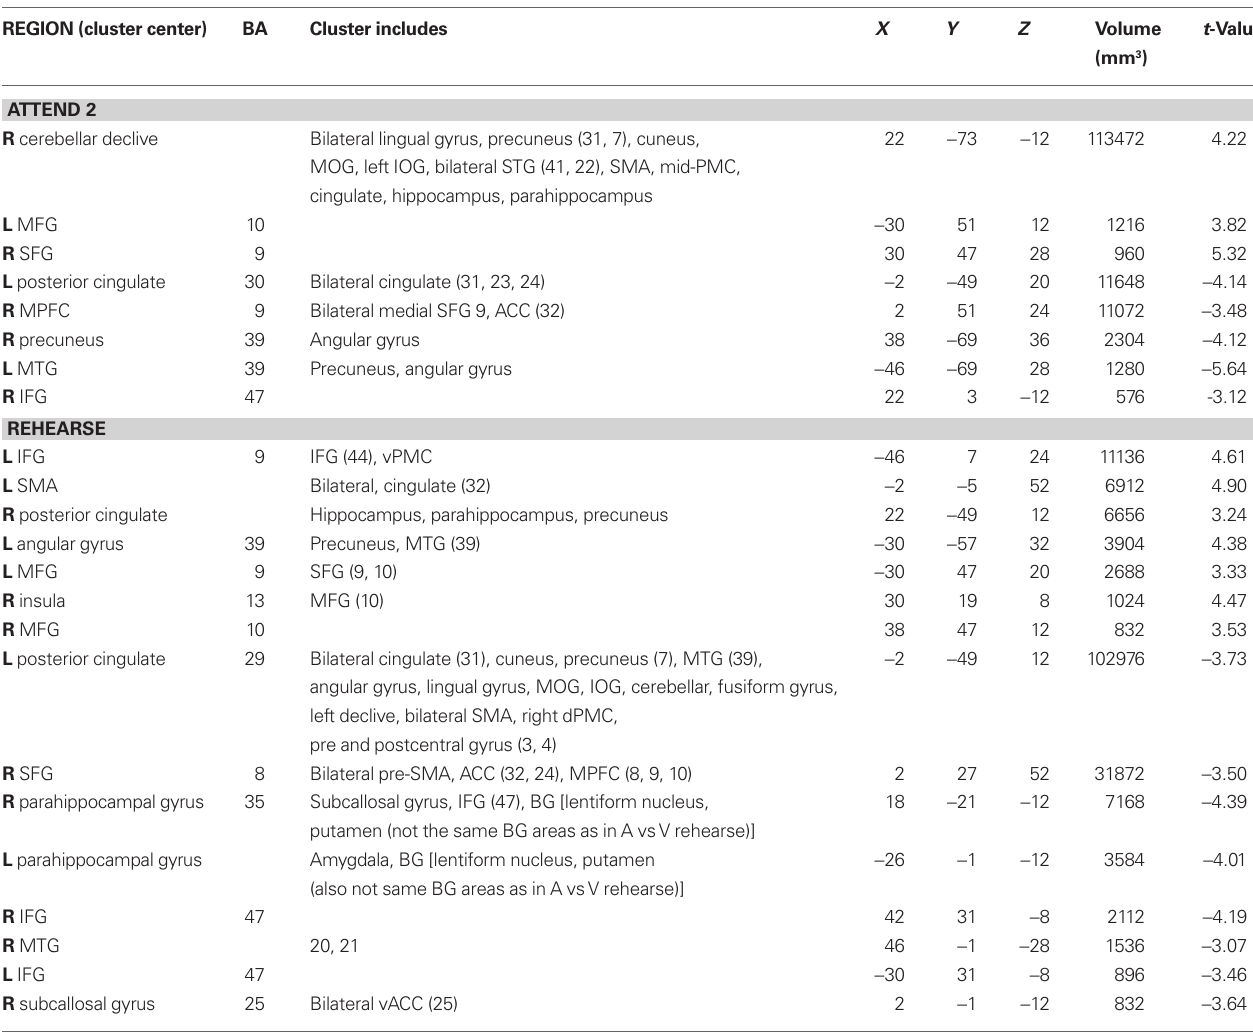
Table 4 | Visual attend 2 and rehearse compared to rest ( p < 0.002 corrected). RegIOn (cluster